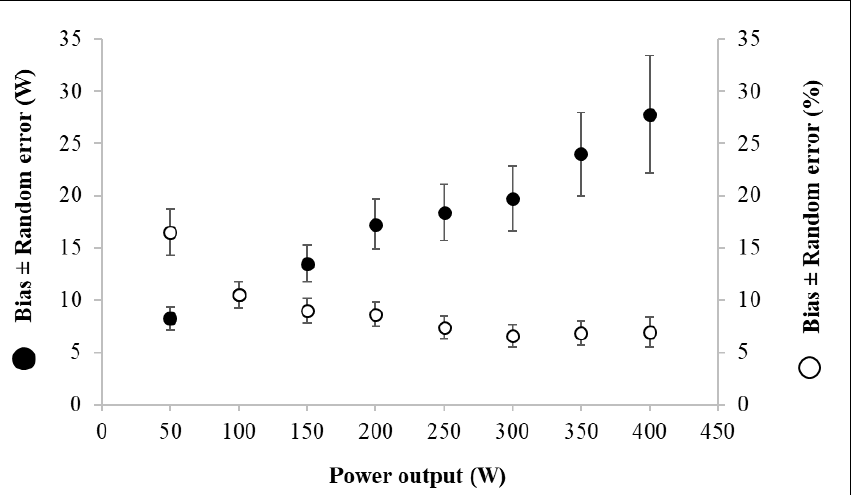
Figure 5. Comparison between two power meters (personal data). The graph represents the absolute bias ± random error expressed in Watt (black markers) and the relative bias ± random error expressed in % (white markers) for each power output (PO) level tested.